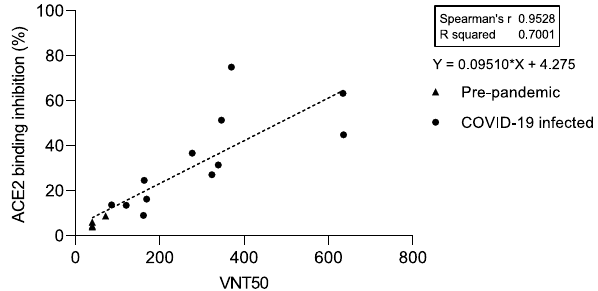
Figure 1. Comparison between RBDCoV-ACE2 and a virus neutralization test (VNT). Serum samples (n = 16) of pre-pandemic (n = 4) and COVID-19 convalescent (n = 12) individuals were measured using both assays and analyzed by linear regression. The equation of the dashed regression line is shown next to the graph. VNT results are depicted as half-maximal inhibiting serum dilutions (VNT50), RBDCoV-ACE2 results are shown in percentage inhibition of ACE2 binding. Correlation analysis was performed after Spearman and the correlation coefficient r is